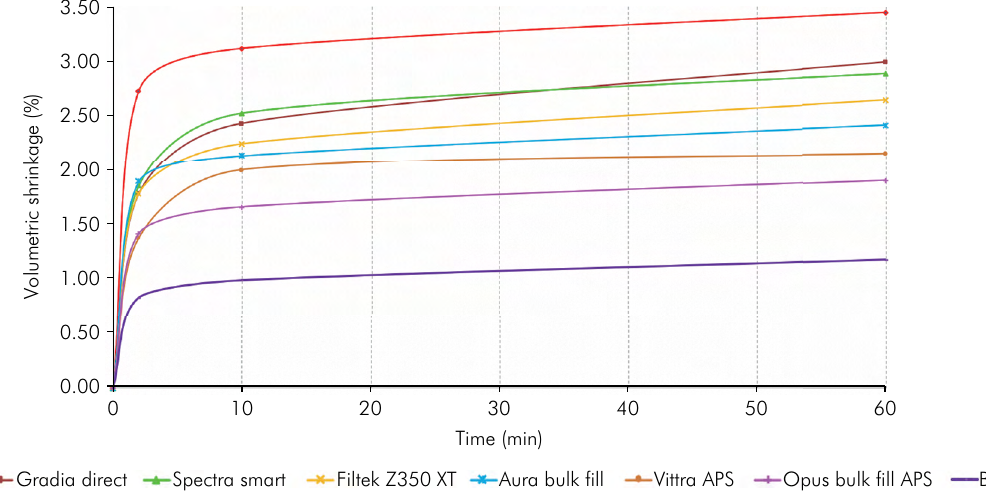
Figure 3. Total shrinkage (volume %) for the eight restorative composites against time (0–60 min).